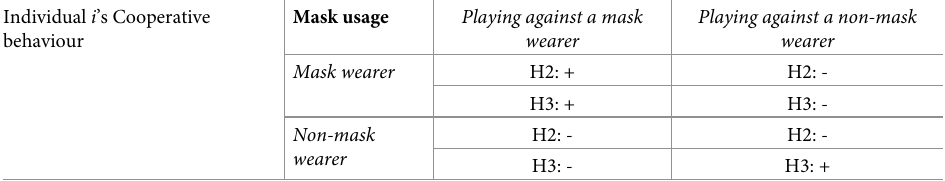
Table 1. Predictions of mask and non-mask wearers’ cooperative behaviours when information about the other player’s mask usage is revealed. Individual i ’s Cooperative